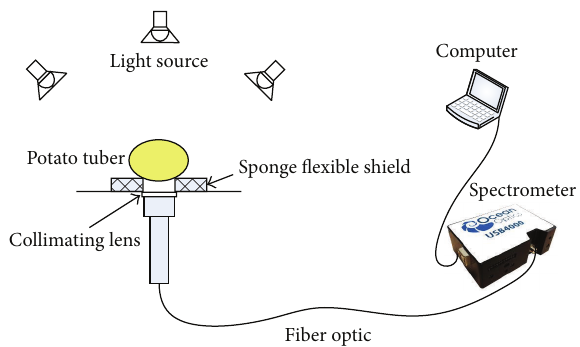
Figure 1: General sketches of the measurement